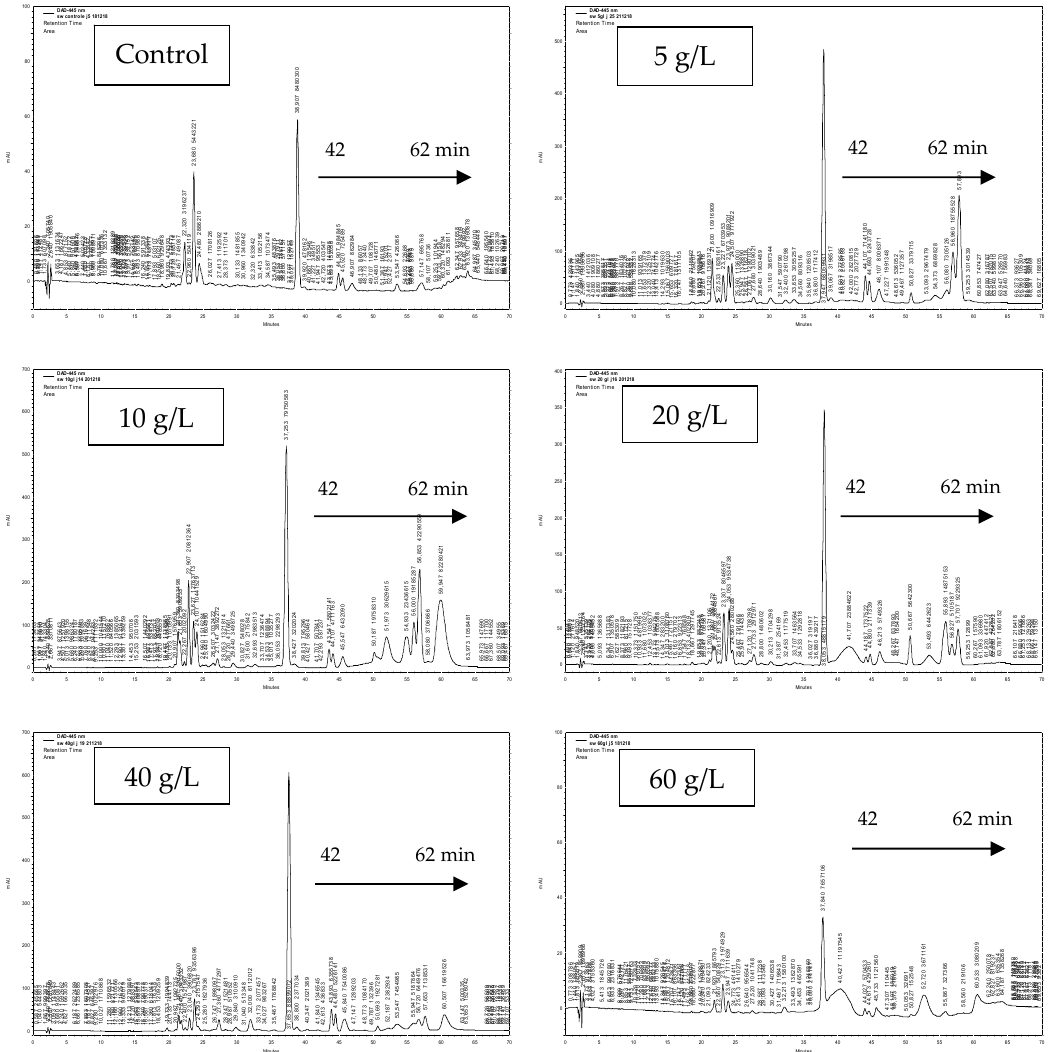
Figure 2. HPLC profiles of pigments detected in the control and the stressed Scenedesmus sp. Control: Scenedesmus sp. cultured in MDM medium without salt. The stressed Scenedesmus sp. was cultured under 5, 10, 20, 40, and 60 g/L of NaCl concentrations.